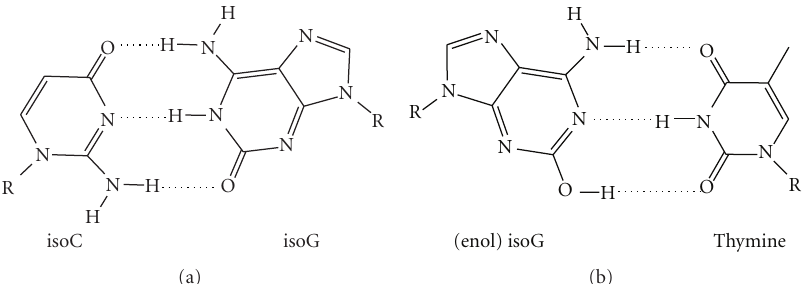
Figure 8: isoC, isoG, and their base pairs (a) isocytosine: isoguanosine and (b) (enol) isoG:thymine